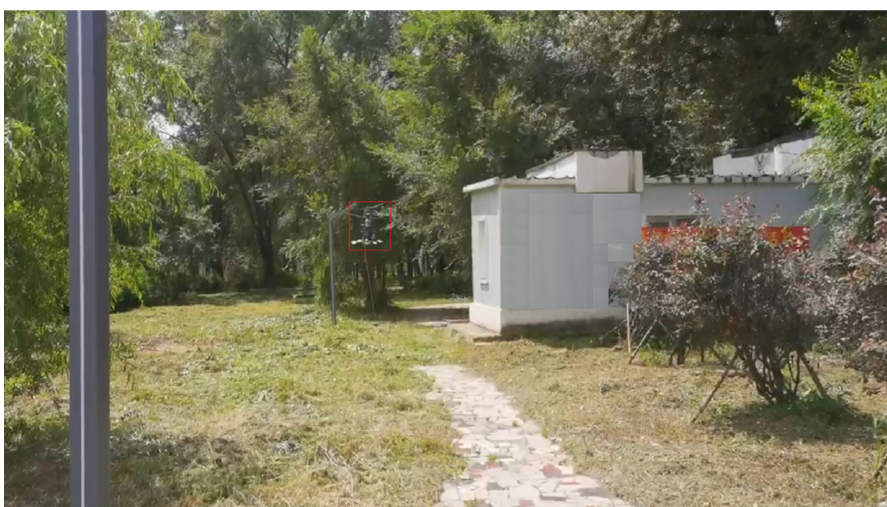
Figure 15. Actual flight test figure.